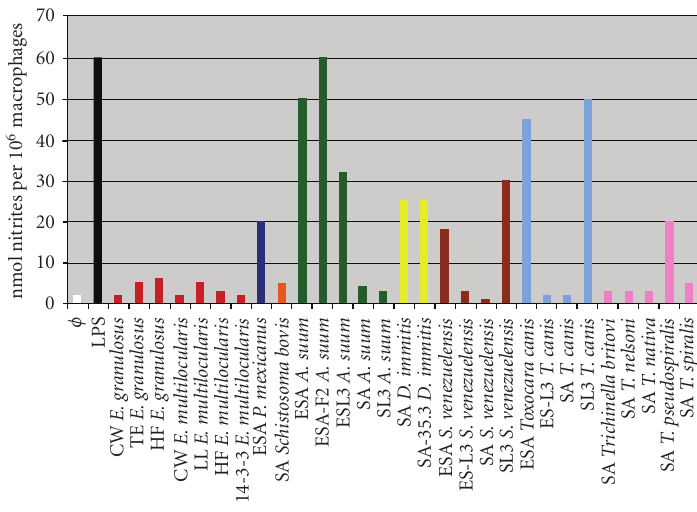
Figure 1: E ff ect of NO production by alveolar macrophages stimulated with di ff erent helminth antigens. Nonstimulated ( φ ), LPS-stimulated macrophages (LPS), cyst wall (CW), total extract (TE), hydatid fluid (HF), soluble laminated-layer (LL), E14t recombinant 14-3-3 protein (E14t), excretory-secretory adult (ESA), and somatic adult (SA), excretory-secretory larvae (ESL3), somatic larvae (SL3). Helminths are represented in di ff erent